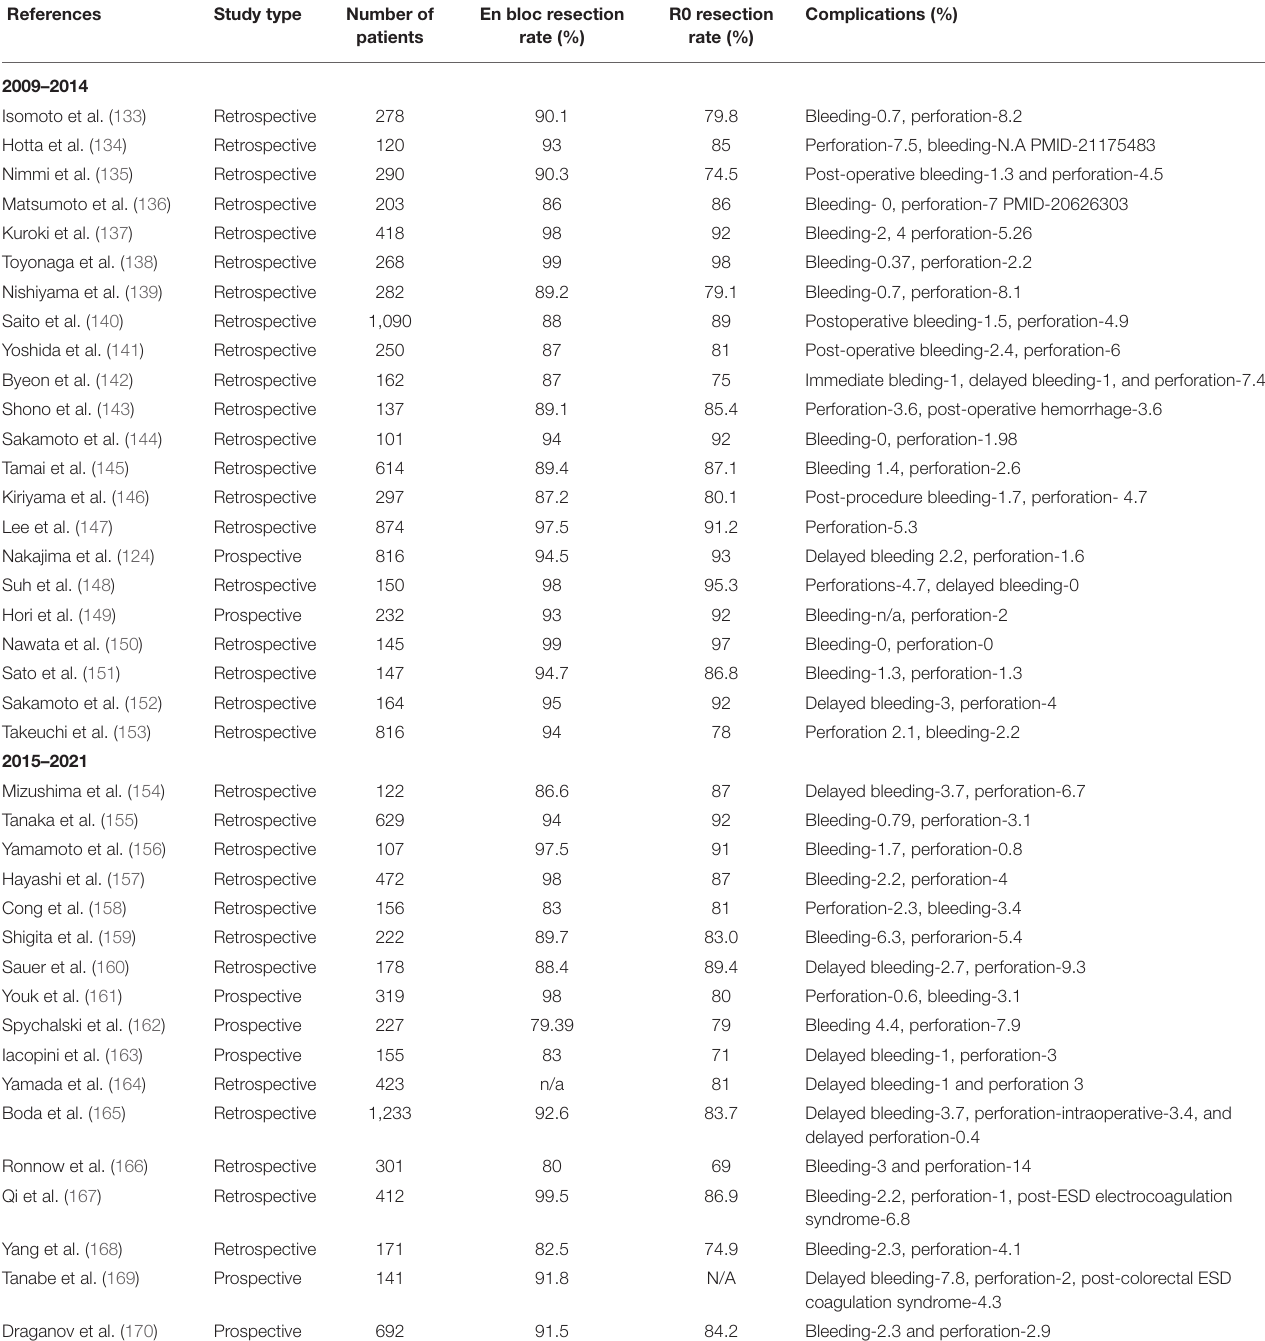
TABLE 2 | Endoscopic submucosal dissection (ESD) for colon polyp studies with more than 100